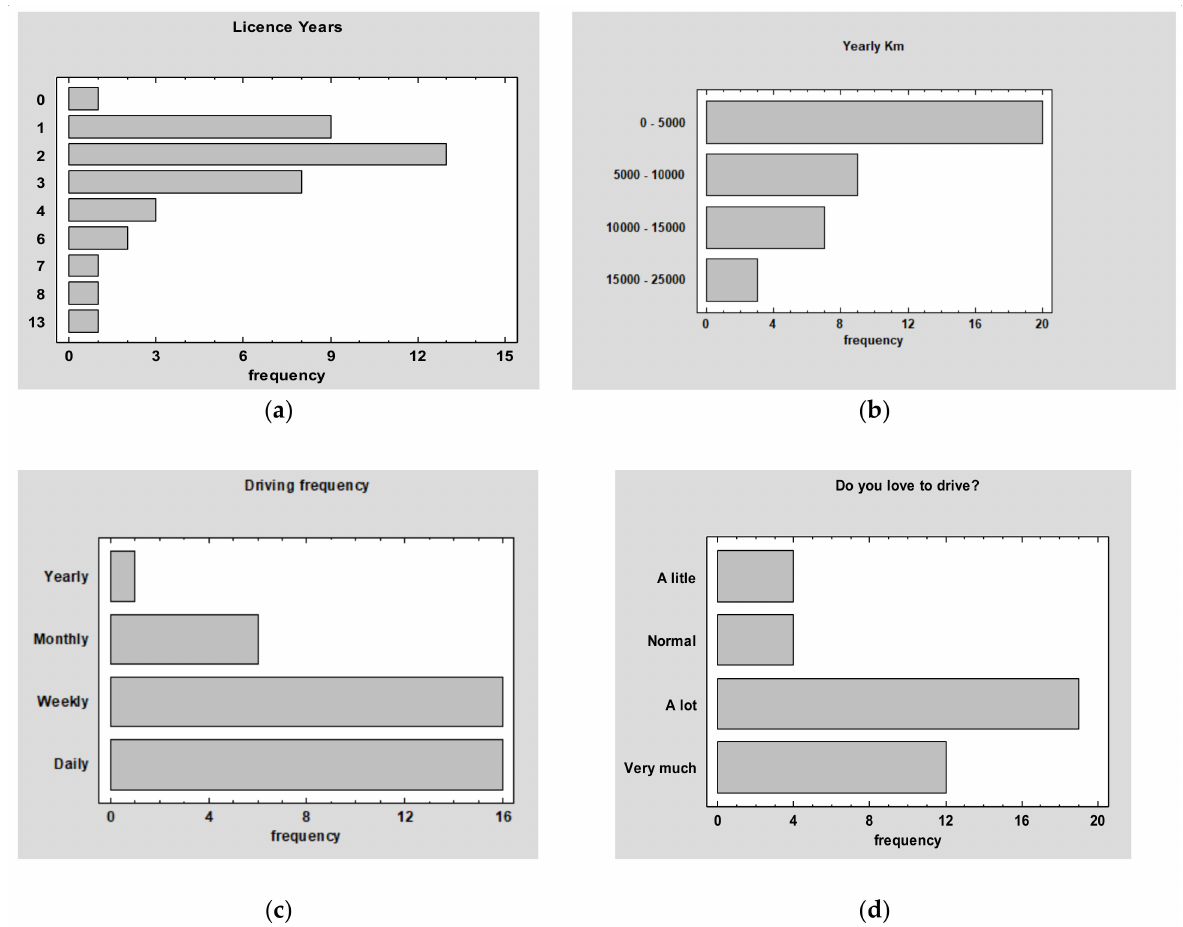
Figure 1. Descriptive of the study sample: ( a ) Frequency of the license years; ( b ) Km driven per year; ( c ) Driving frequency between daily, weekly, monthly and yearly; ( d ) How much the participants love to